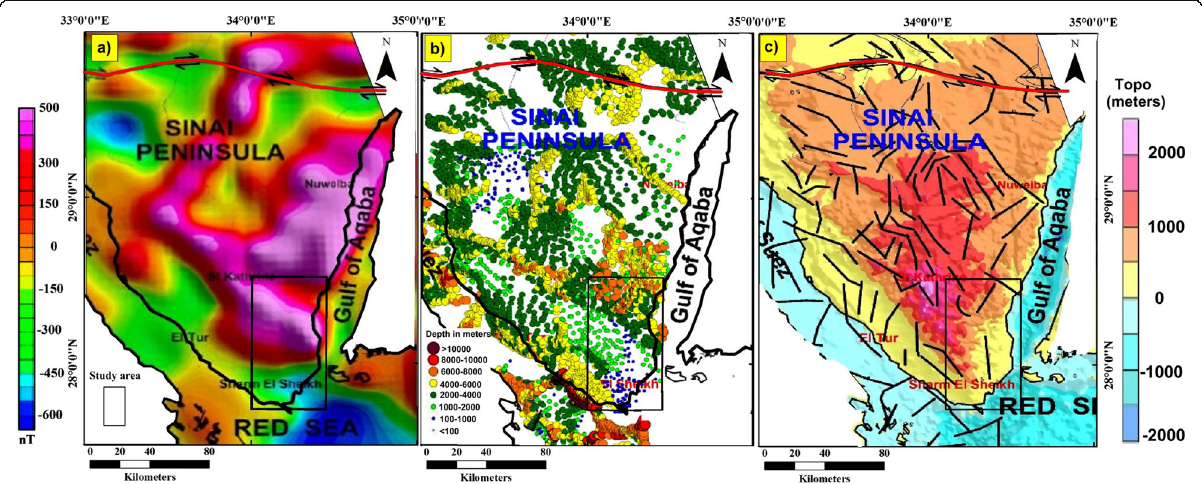
Fig. 8 Aeromagnetic data derivatives of south Sinai (Saleh and Saleh 2012). a Reduced to pole (RTP) aeromagnetic map of south Sinai area. b Euler deconvolution map derived from the aeromagnetic data illustrates the depth values of the extracted major structural trends, where the depths along the coastal area are ranging between 100 and 1000 m. c Deduced structural map derived from the 3D Euler deconvolution solution where all major tectonic features could be